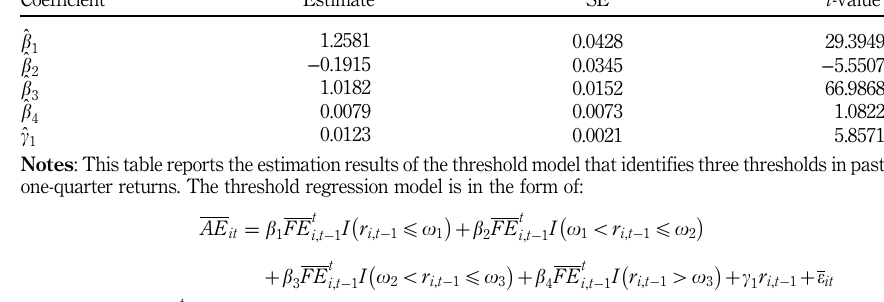
Table III. Estimation results of the threshold model with three thresholds in past one-quarter